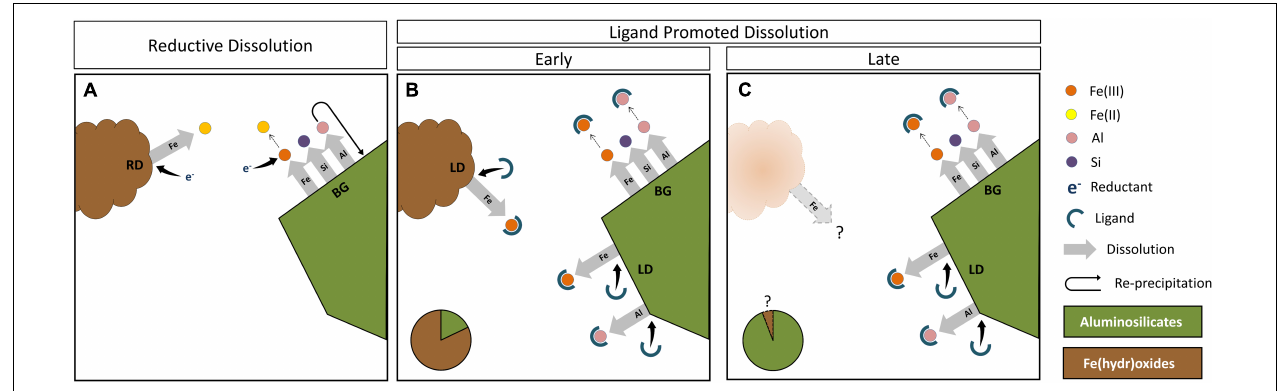
FIGURE 7 | A schematic representation of the major dissolution pathways and principal minerals contributing to the release of Fe, along with Al and Si, into seawater from dust, via two mechanisms employed by phytoplankton. The presence of a reductant (A) enhances the dissolution rate of Fe(hydr)oxides (RD), but not that of aluminosilicates, which dissolve at a background rate (BG). Dissolved Fe is maintained in solution in its reduced and more soluble form, Fe(II). The presence of the siderophore (B,C) enhanced the dissolution of both Fe(hydr)oxides and aluminosilicates (SD). Complexation of both Fe and Al by the siderophore prevent their precipitation as (hydr)oxides and allows accumulation in solution. In early SD (B) , Fe release was poorly correlated to Si and Al release, indicating that Fe(hydr)oxides were the main dissolving Fe pool. In contrast, in late SD (C) , Fe release was strongly correlated to Al and Si release, indicating that Fe-bearing aluminosilicates were the main dissolving Fe pool. The relative contribution of the different Fe-pools in the presence of a siderophore is depicted in the pie-charts in B,C . The pie piece with the question mark represents a small, unquantified contribution from another Fe pool.